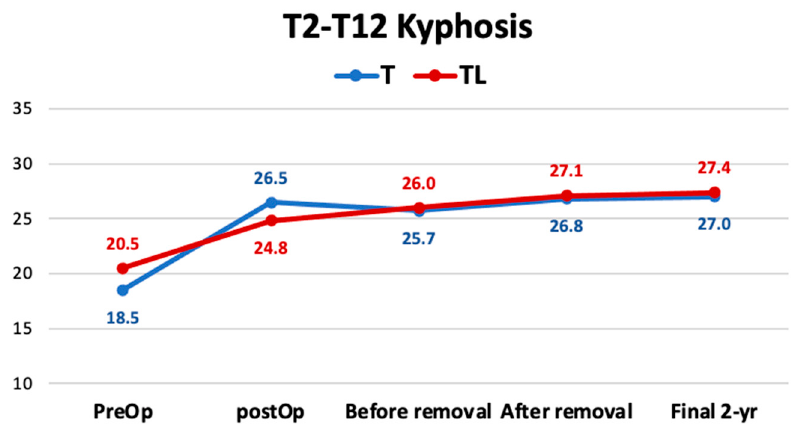
Figure 5. Angular value of the thoracic kyphosis from T2 to T12.